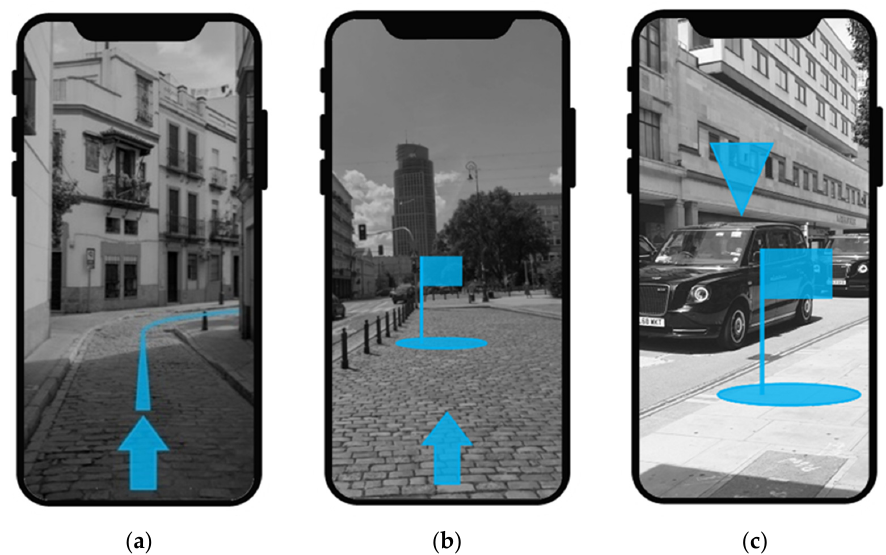
Figure 1. AR interface for the 3 phases of the user journey: ( a ) navigation to the vStop with orientation (added post hoc) and pathway element; ( b ) identifying the vStop with orientation and standing subject element (waiting area was included post hoc); and ( c ) identifying SAV with waiting area and object highlighting element (standing subject element was included post hoc).